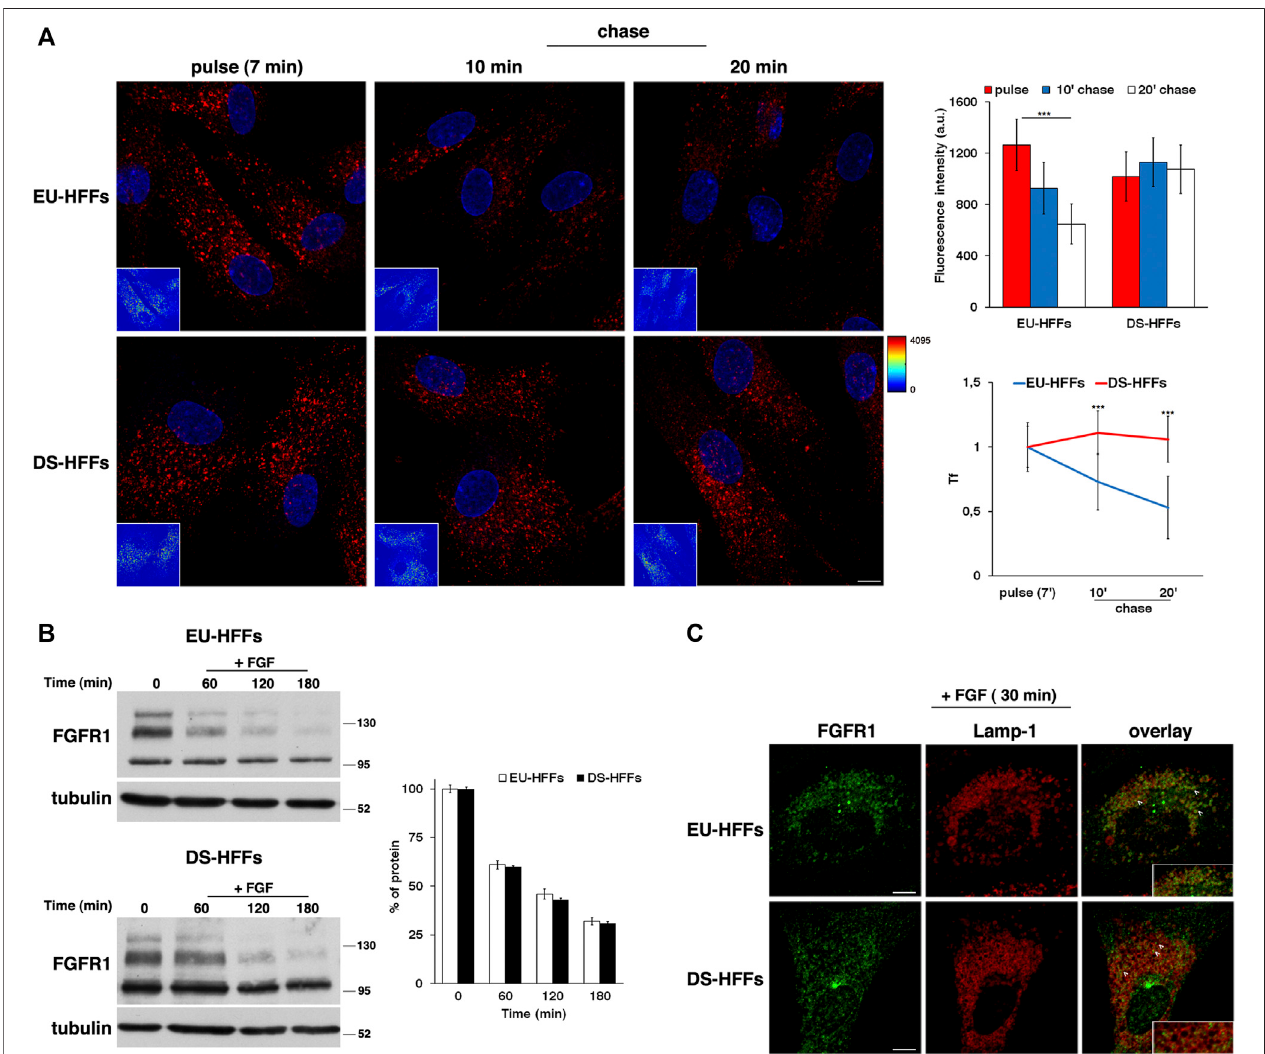
FIGURE 4 | The recycling traf fi cking, but not the traf fi c toward lysosomes, is perturbed in DS-HFFs. (A) The internalization assay of Alexa-546-conjugated transferrin (Tf) in EU-HFFs and DS-HFFs. Tf was added to the cells at 37 ° C for 7 min (pulse). After washing out, cells were incubated in culture medium for different indicated times (chase). Representative confocal images and corresponding intensity maps in the insets (enlarged pictures in Supplementary Figure S1 ) are shown; scale bars, 8 μ m. Note that the fl uorescent signal of Tf decreased over time in EU-HFFs, while it remained constant in DS-HFFs. Mean fl uorescence intensity (arbitrary unit, a.u.) of Tf is shown (upper graph); error bars, mean ± SD of three independent experiments, n ≥ 40 cells. Curves of Tf internalization expressed as mean values of fl uorescence measured at chase times compared with the fl uorescent signal after the pulse (set to 1) are shown (lower graph). (B) Representative immunoblotting of FGFR1 upon FGF stimulation. Cells were serum starved for 16 h (time) and incubated with FGF (10 ng/ml) for different times (see Materials and Methods ). Tubulin was used as the loading control. The molecular weight of protein markers is indicated. The three bands detected for FGFR1 in both euploid and trisomic cells represent two glycosylated, mature and immature, forms (upper and intermediate band, respectively) and a non-glycosylated form (lower band), as previouslydescribed(Yingetal.,2020).Densitometricanalysisofthreeindependentexperimentsisshown,andtheresultsareexpressedasapercentage oftheamount of protein at time 0. Error bars, mean ± SD. (C) Cells treated as in (B) were fi xed and stained with FGFR1 (green) and Lamp-1 (red) antibodies. Representative images corresponding to 30 min of FGF incubation are shown; scale bars, 8 μ m. After internalization, FGFR1 localized in cytoplasmic punctate structures, some of which were co-localized with Lamp-1 positive dots (see arrows). A region of cell at higher magni fi cation is shown in the insets. *** p < 0.001, Student ’ s t